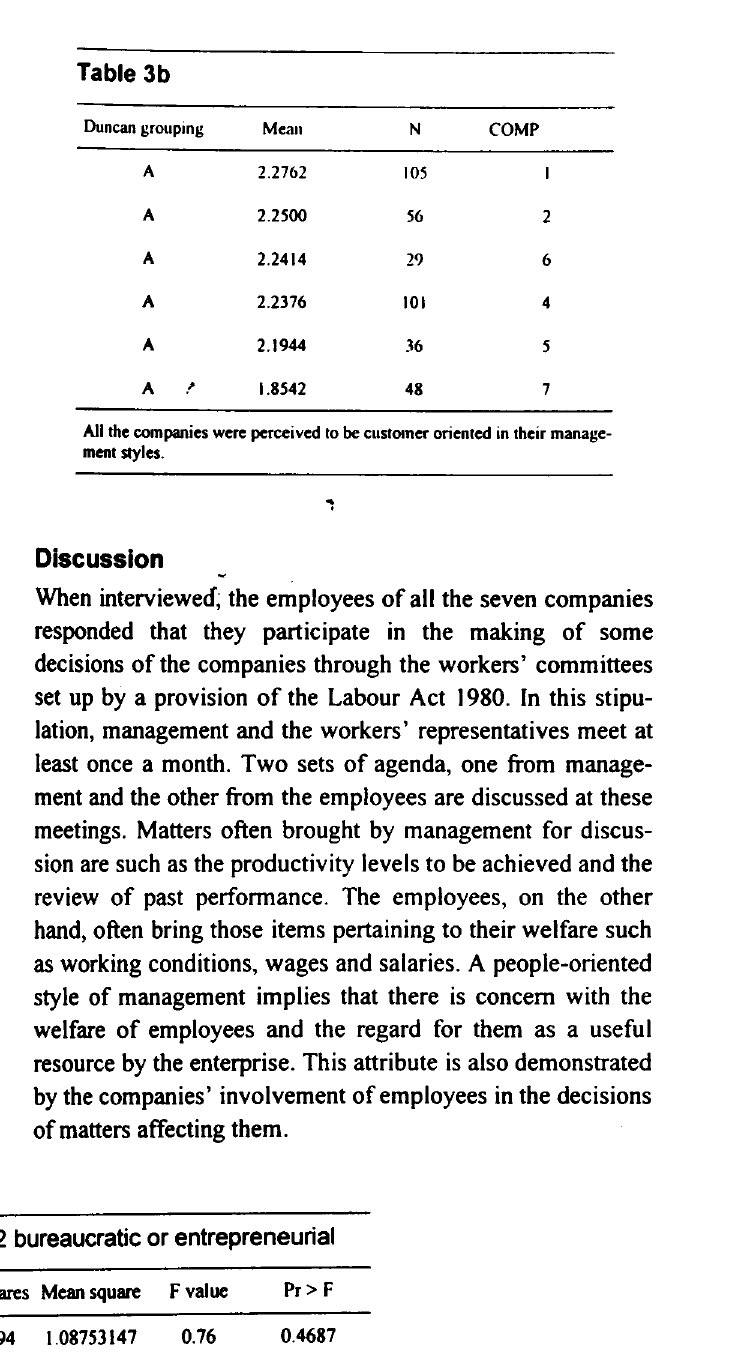
Table 4a Dependent variable: V2 bureaucratic or